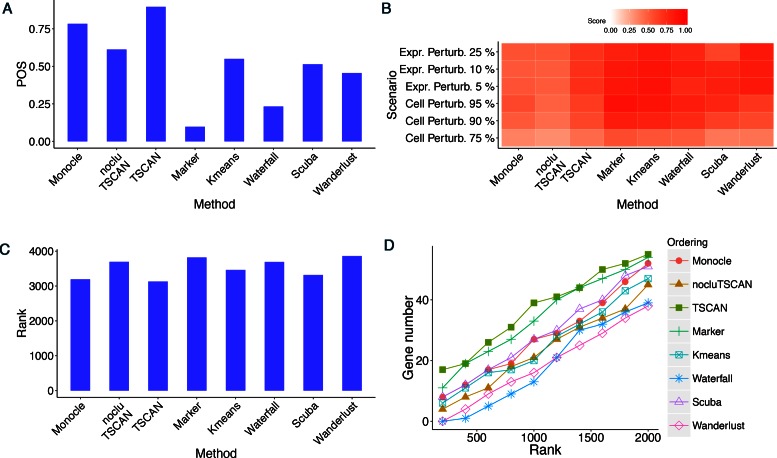
Evaluation results for different methods in LPS data set. (A) POS score.
(B) Robustness measured by the average similarity score from 100
independent perturbations. (C) Mean rank of gold standard genes.
(D) Number of detected gold standard genes among top differential
genes.